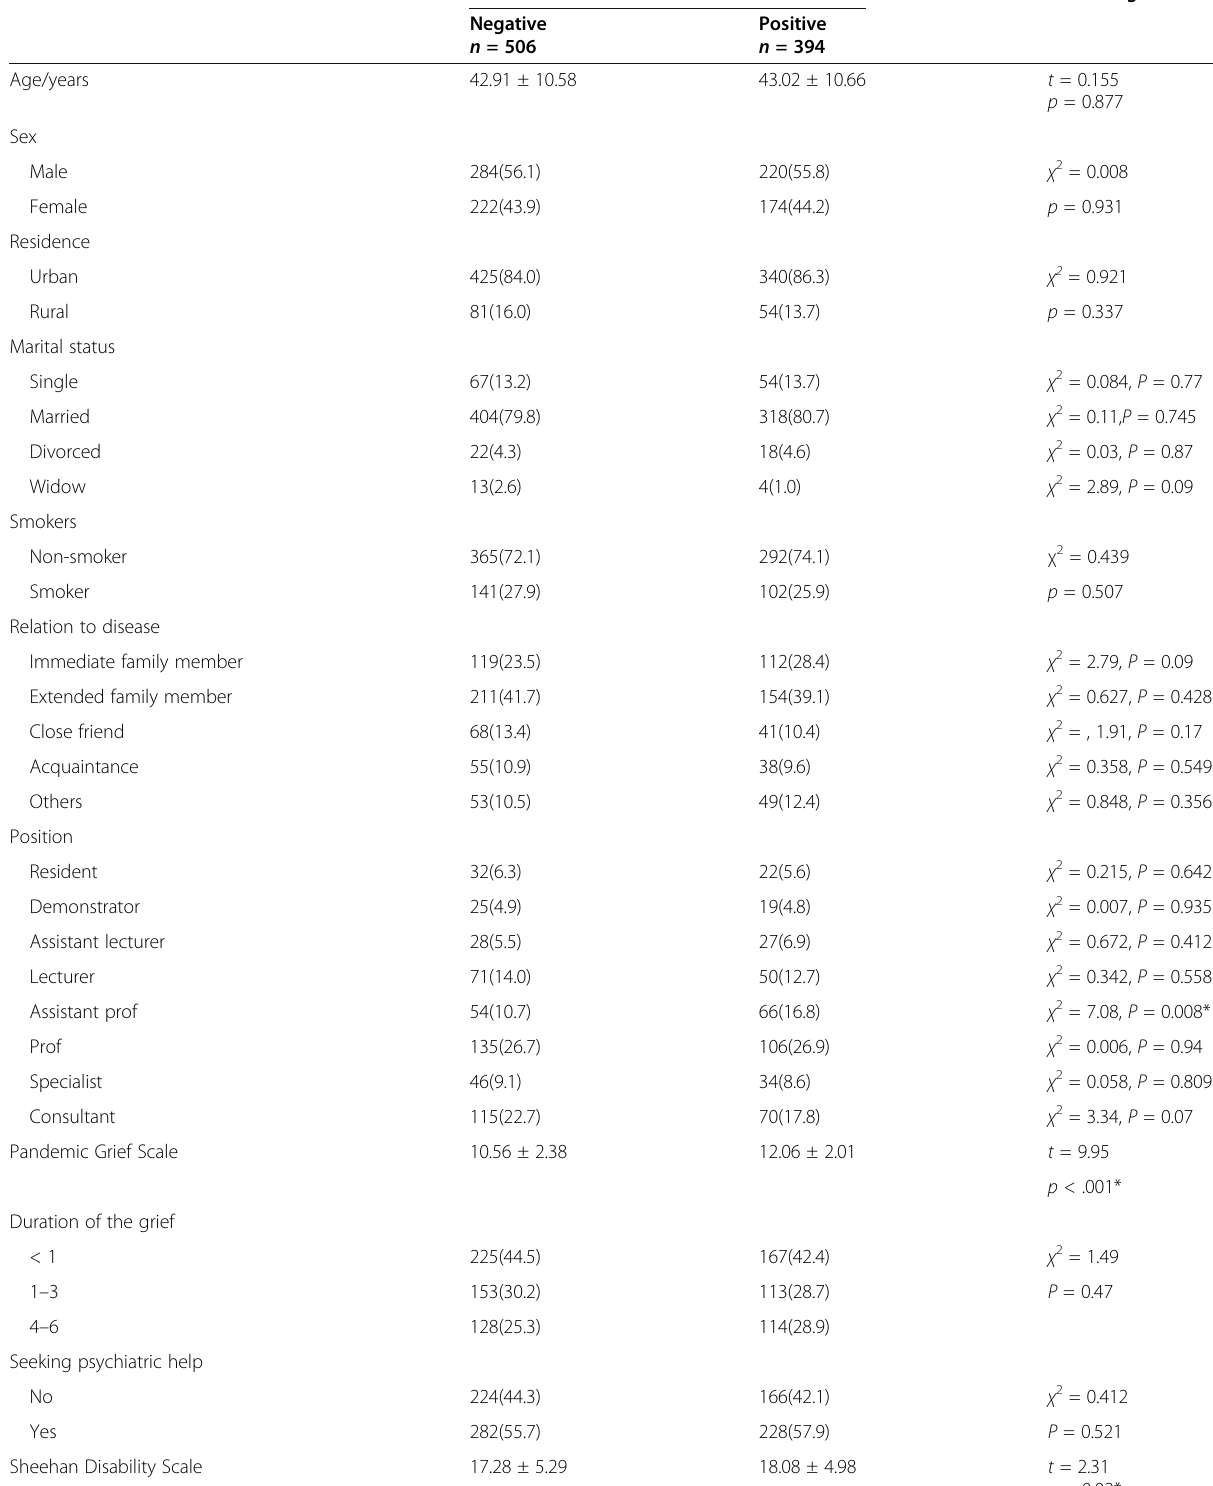
Table 2 Association between socio-demographic, Sheehan Disability Scale, Pandemic Grief Scale, and COVID-19 infection